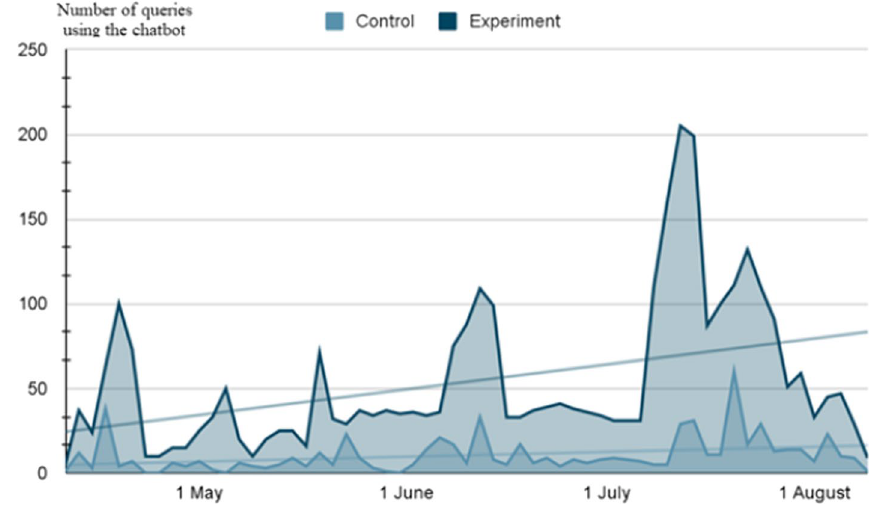
Fig. 5 Daily queries by students